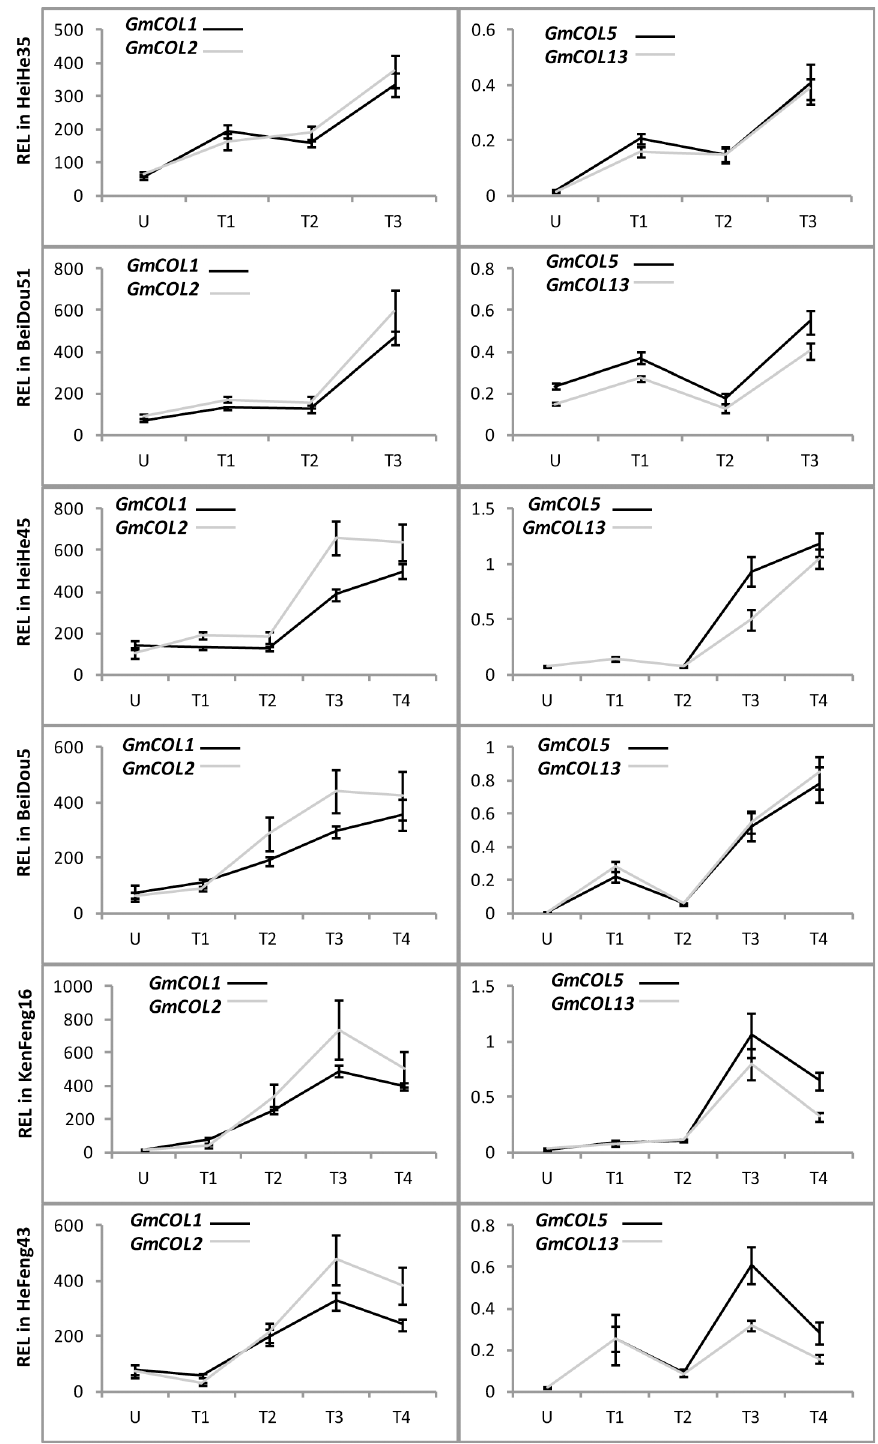
Fig 6. Relative expression level analyses of GmCOL s in six soybean cultivars at different stages. Relative expression levels (REL) were analyzed by RT-qPCR and normalized to UKN1 . Averages and standard errors are the result of three replicates. For detailed information on stages and sampling, see Materials and Methods